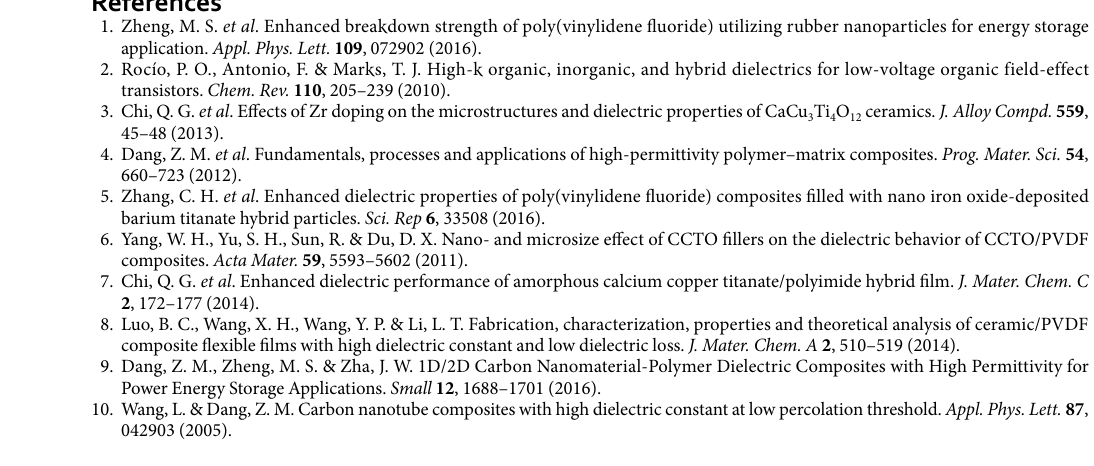
vigorous stirring at room temperature for 15 min. Then, the obtained mixture was transferred into a 200 ml Teflon-lined stainless steel autoclave. The solvothermal reaction was kept at 120 °C for 4 h, then the precipitate was collected, and washed with distilled water and ethanol until the pH around 7. Finally, the Fe 3 O 4 -LDPE par- ticles were obtained and dried under vacuum at 50 °C for 12 h. The volume fractions of Fe 3 O 4 in the Fe 3 O 4 -LDPE particles were 0.2 vol.%, 0.9 vol.%,1.9 vol.%, 3.0 vol.%, 4.2 vol.%, and 7.0 vol.%, respectively. Preparation of Fe O /LDPE composites. Before preparing the composites, the 0.6 g Fe 3 4 3 O 4 -LDPE parti- cles were dispersed in a 200 mL Tris-HCl aqueous solution (10 × 10 − 3 M, pH = 8.5) followed by sonication for 1 h; then 0.2 g DA-HCl was added and sonicated for another 10 min. The mixture was then stirred vigorously at room temperature for 4 h, and the excess supernatant was removed after sedimentation for about 1 h. The Fe 3 O 4 -LDPE particles were obtained and dried under vacuum at 50 °C for 12 h. The Fe 3 O 4 /LDPE composites were obtained by a torque rheometer for 30 min at 130 °C and then molded by hot pressing at approximately 130 °C and 15 MPa for 20 min. The M-Fe 3 O 4 /LDPE composites were obtained by treating at 130 °C under a vertical direction mag- netic field with a magnetic induction density of 1.0 T for 30 min. The preparation process of the Fe 3 O 4 /LDPE and M-Fe 3 O 4 /LDPE composites is shown in Fig. 8. The morphology of the Fe 3 O 4 -LDPE particles and the microstructure of the LDPE com- posites were observed using SEM (Quanta 200 FEI). The phase compositions of the Fe 3 O 4 /LDPE composites were analyzed using XRD (Empyrean), using Cu K α radiation at 40 kV and 40 mA. The thermal diffusivity ( α ) and specific heat ( C ) were measured on the disk samples with an LFA447 light flash system (NETZSCH, Selb, Germany) at 25 °C. The thermal conductivity was calculated by λ = α C ρ , in which ρ is the density of the Fe 3 O 4 / LDPE composite. Prior to performing dielectric measurements, a layer of Al paste (diameter 25 mm) was evap- orated on both surfaces to serve as electrodes. Dielectric measurements were employed across a frequency range from 10 to 10 6 Hz and a temperature range of − 10 °C to 105 °C using a broad frequency dielectric spectrometer (Novocontrol Alpha-A).